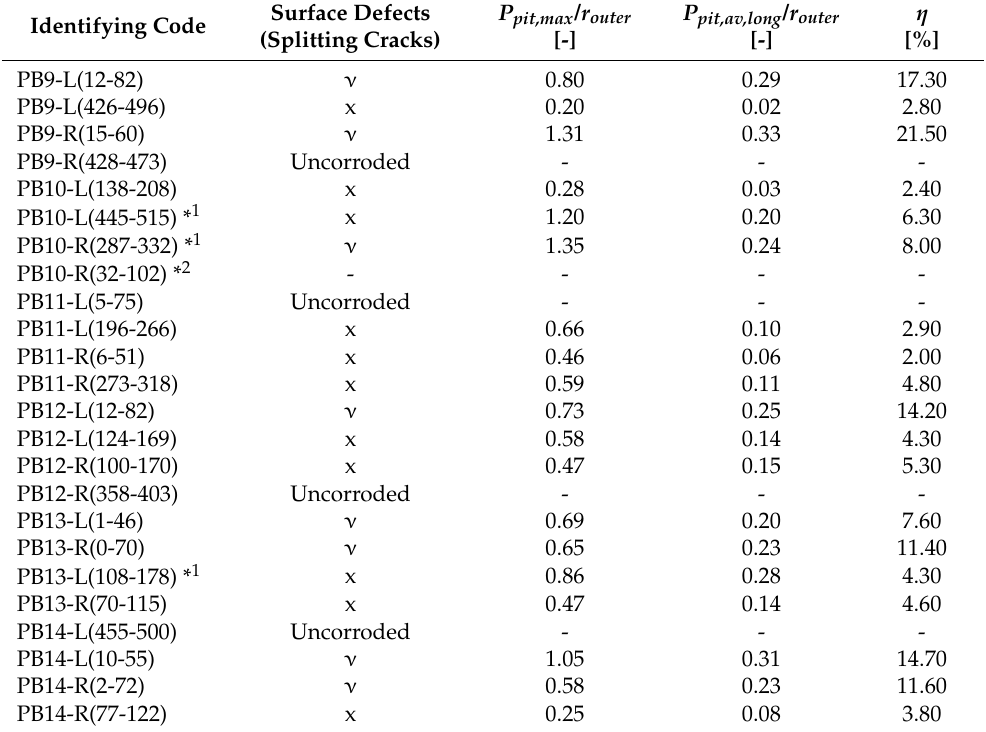
Table 1. Characterization of pitting corrosion of retrieved corroded prestressing strands.